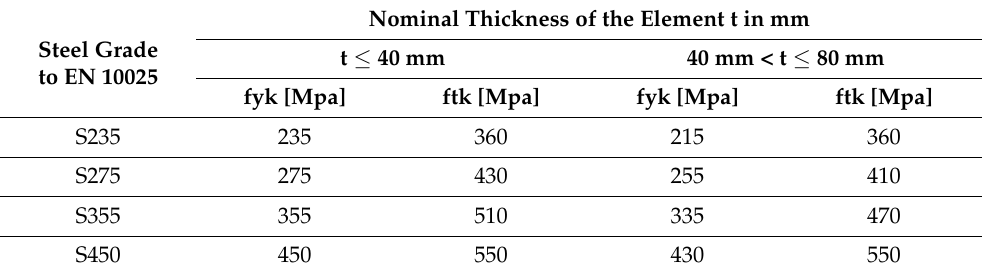
Figure 15. Development of admissible maximum displacement constraint algorithm for road bridges in Grasshopper. Table 6. Mechanical properties of structural steels produced to EN 10025, under EN